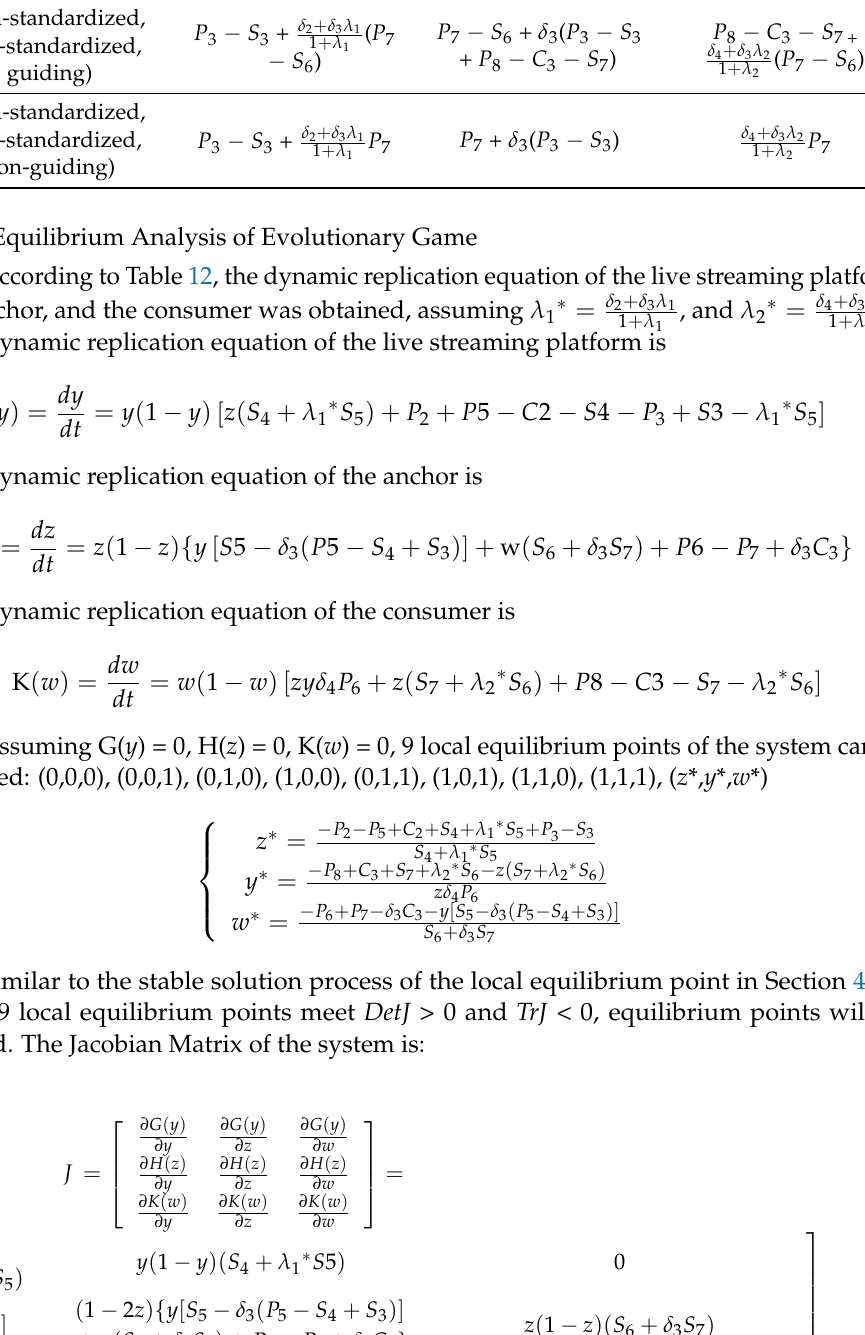
Live Streaming Platform